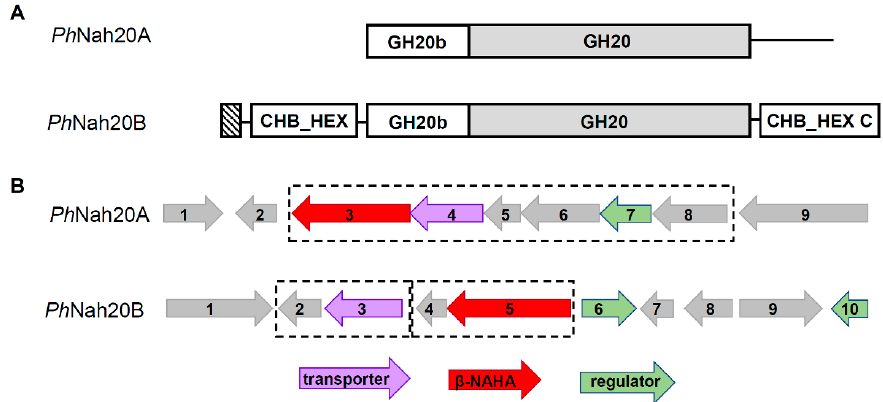
Figure 1. Schematic domain architecture of P. hydrolytica Ph Nah20A and Ph Nah20B ( A ) and of genomic regions flanking the two putative β - N -acetylhexosaminidases ( β -NAHAs) (red arrows) ( B ). ( A ) GH20 catalytic domains are gray and the N -terminal signal peptide is striped. ( B ) Predicted protein functions are color coded. The information was retrieved from the National Center for Biotechnology Information (NCBI) database (NZ_LSNE01000003.1), Uniprot and Pfam databases. The regions flanking Ph Nah20A (3): 1, LemA family protein; 2, hypothetical protein; 4, sodium:solute symporter, putative SLC5sbd family protein; 5, RidA (reactive intermediate/imine deaminase A) family protein; 6, D -aminoacylase; 7, MurR/RpiR family transcriptional regulator; 8, amino acid deaminase; 9, sodium/proton-translocating pyrophosphatase. The regions flanking Ph Nah20B (5): 1, TonB-dependent receptor; 2, DUF1624 domain-containing protein, putative acyltransferase; 3, glucose/galactose MFS transporter; 4, hypothetical protein, putative BadF-type ATPase; 6, LacI family DNA-binding transcriptional regulator; 7, dCTP deaminase; 8, iron–sulfur cluster carrier protein ApbC; 9, methionine-tRNA ligase; 10, TetR/AcrR family transcriptional regulator. Predicted operons are in dashed frames.